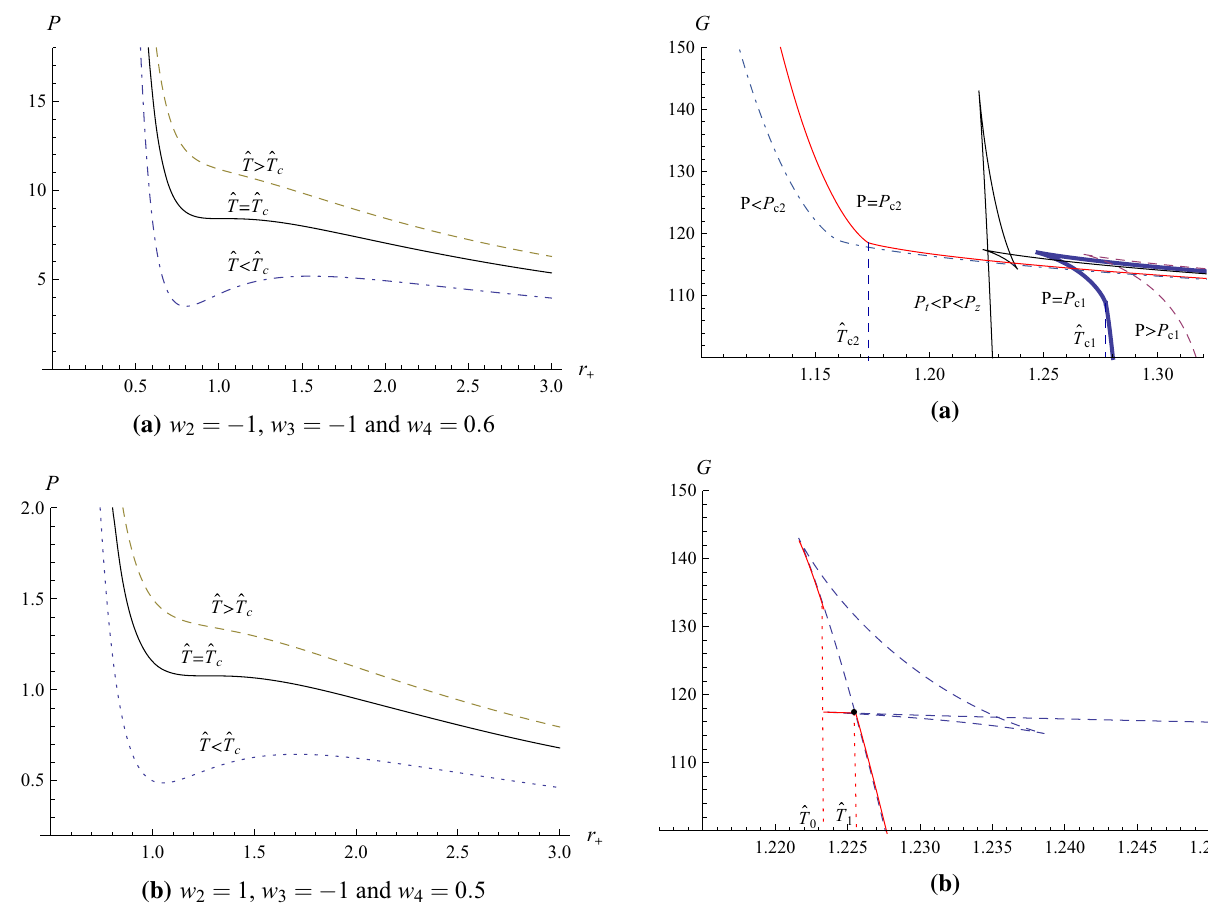
ˆ T = ˆ T c isdenotedbythe solidline .The